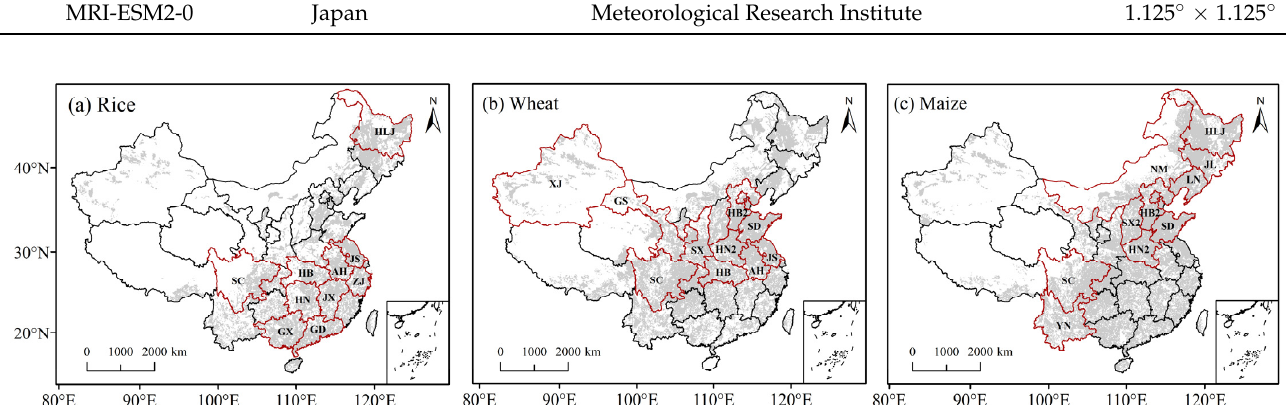
of long-term variations, such as changes in crop management and technological advance-